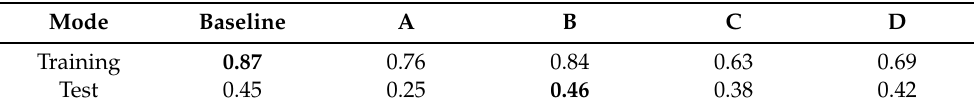
Table 22. Compared results of mIoU scores from the Rice blast experiments (Bold values show maximum